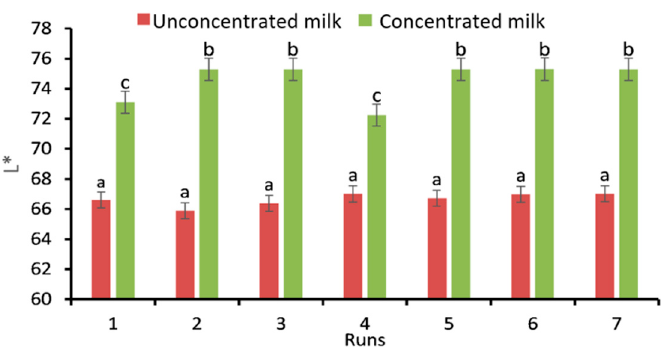
Figure 3. L* value of unconcentrated and concentrated milk. Different letters refer to significant differences between means.